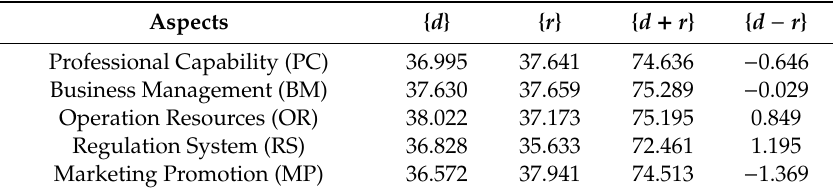
Table 9. The degree of full influence.